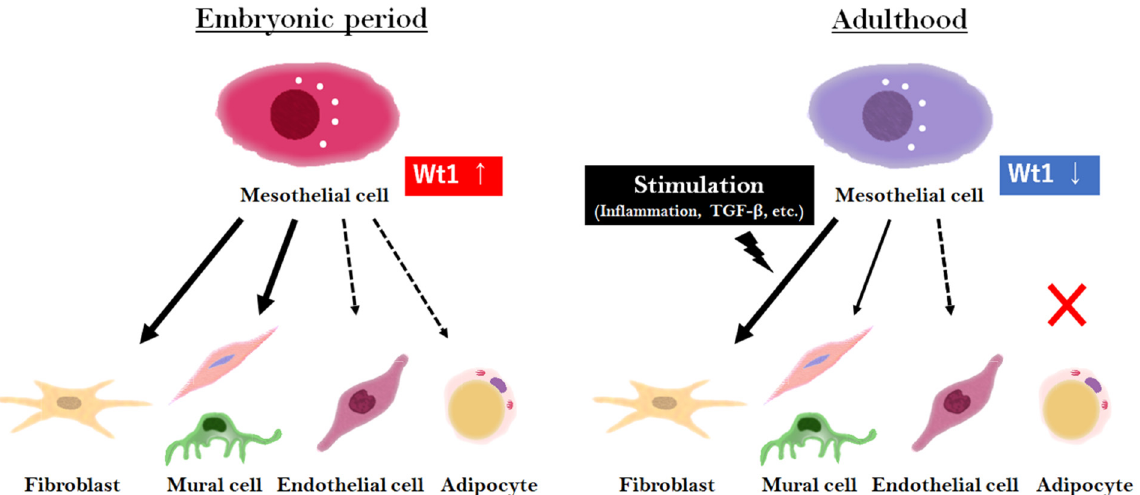
Figure 1. Overview of MC differentiation in the embryonic and adult stages. In the embryonic period, MCs highly express Wt1 , contributing to various tissue formations. In adulthood, Wt1 expression in MCs is low and limited to a few populations, but is involved in tissue repair with differentiation upon stimulation, such as inflammation or injury.